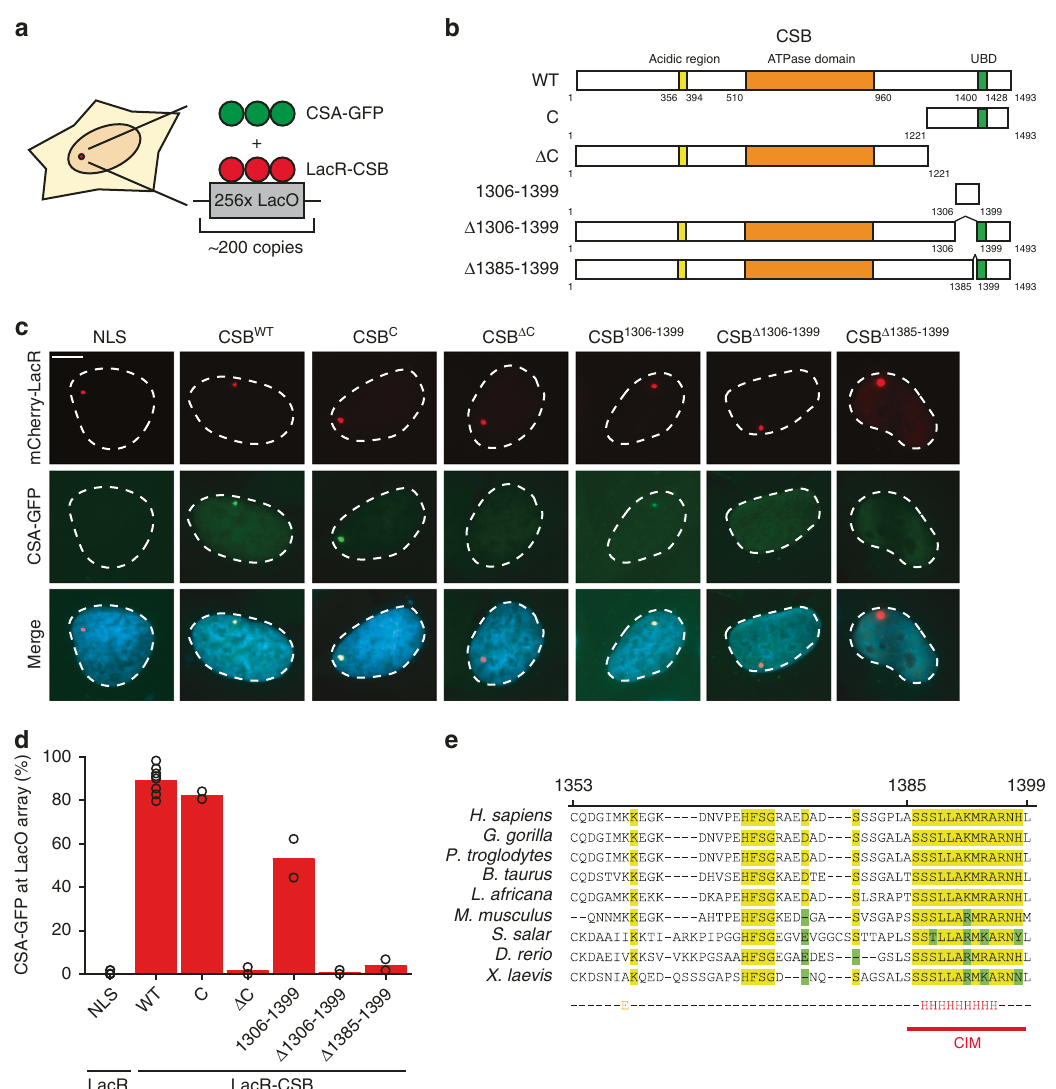
Fig. 2 CSA interacts with the newly identi fi ed C-terminal CIM of CSB. a Outline of the chromatin-tethering approach in U2OS 2-6-3 cells. b A schematic representation of CSB and its deletion mutants. c Recruitment of CSA-GFP to the LacO array upon tethering of the indicated mCherry-LacR fusion proteins (scale bar = 5 µ m). See Supplementary Figs. 3 and 4 for a full overview of all tested mutants. d Quanti fi cation of CSA-GFP and mCherry-LacR-CSB co- localization at the LacO array. Each symbol represents the mean of an independent experiment ( n = 2 for all except LacR-NLS and LacR-CSB WT which is n = 8, >50 cells collected per experiment). e Sequence alignment of CSB orthologues. See Supplementary Fig. 5 for additional alignments. Source data are provided as a Source Data fi fi ndings suggest that the cooperative assembly of the TCR com- plex is important to mediate ef fi cient targeting of UVSSA to lesion-stalled RNAPIIo.